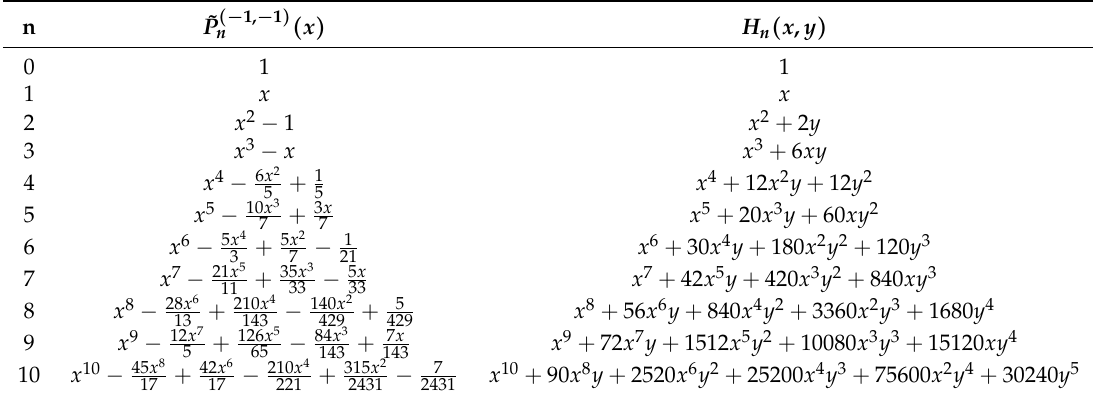
Table A1. Sobolev-Jacobi polynomials ˜ P